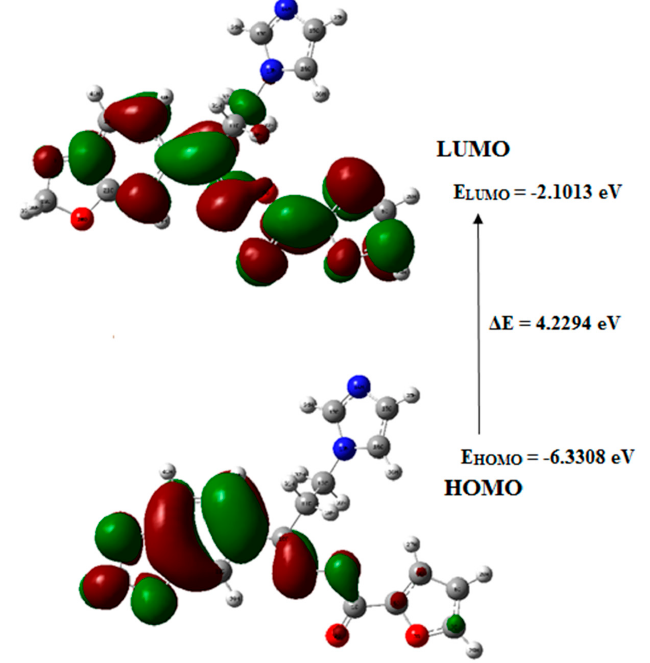
Figure 5. Graphical representation of frontier molecular orbital (FMOs) of the oximino ester 5 ; HOMO: highest occupied molecular orbital; LOMO: lowest unoccupied molecular orbital.